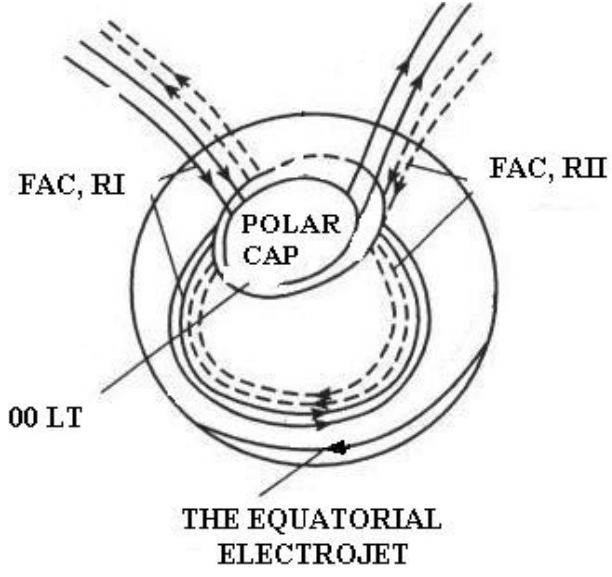
Fig. 6. The model of the field-aligned currents (FAC) of Regions 1 and 2 closing across the equatorial